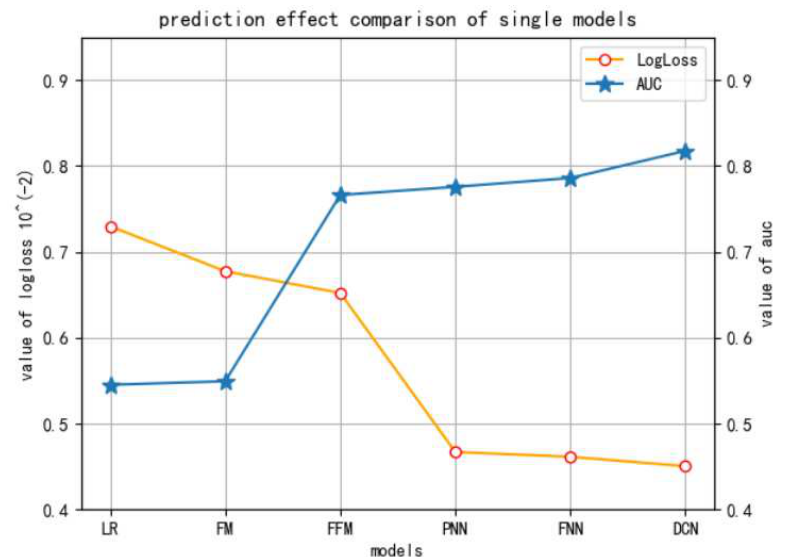
Figure 3. The comparison of single models.